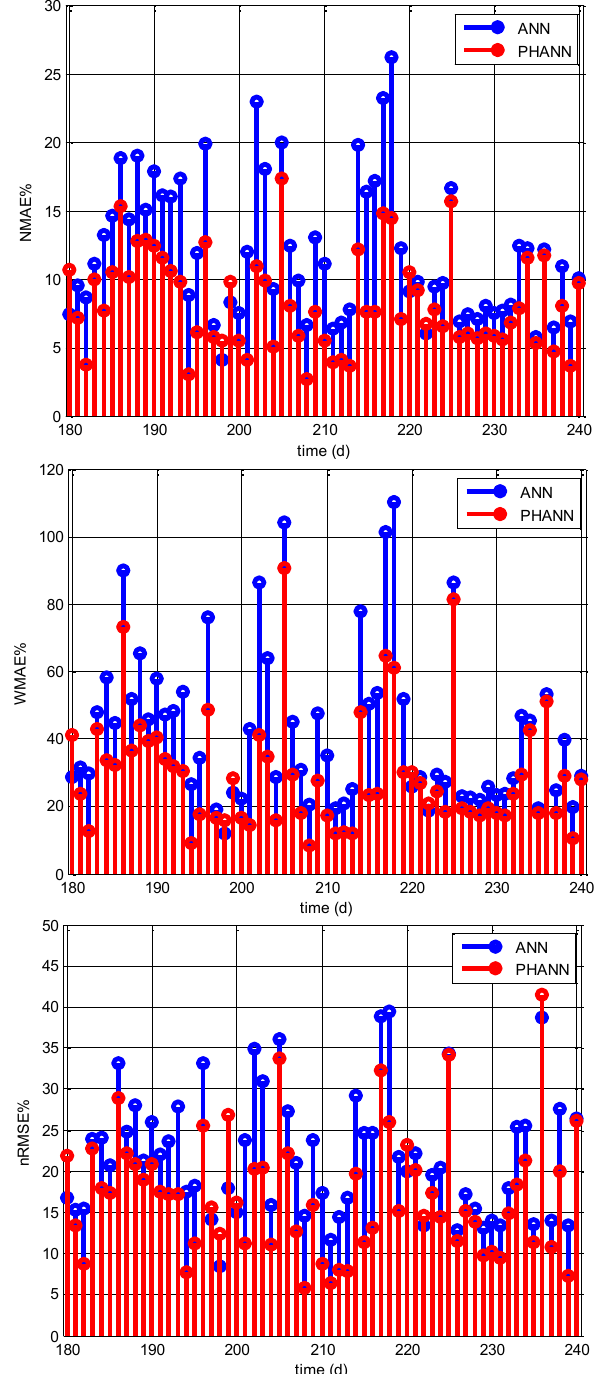
Figure 4. Daily error definitions evaluated for two methods comparison with 120 days of training. The reported errors show that most days, the PHANN method is significantly more accurate than the ANN method. In particular this advantage is quantitatively more significant considering NMAE % , and WMAE % , which reach almost 50% reduction of the error in many days; for the nRMSE % although this reduction is lower, a non-negligible advantage is obtained in most of the days. Similar results have been found considering also the training data sets of 60 and 90 days and different forecasted